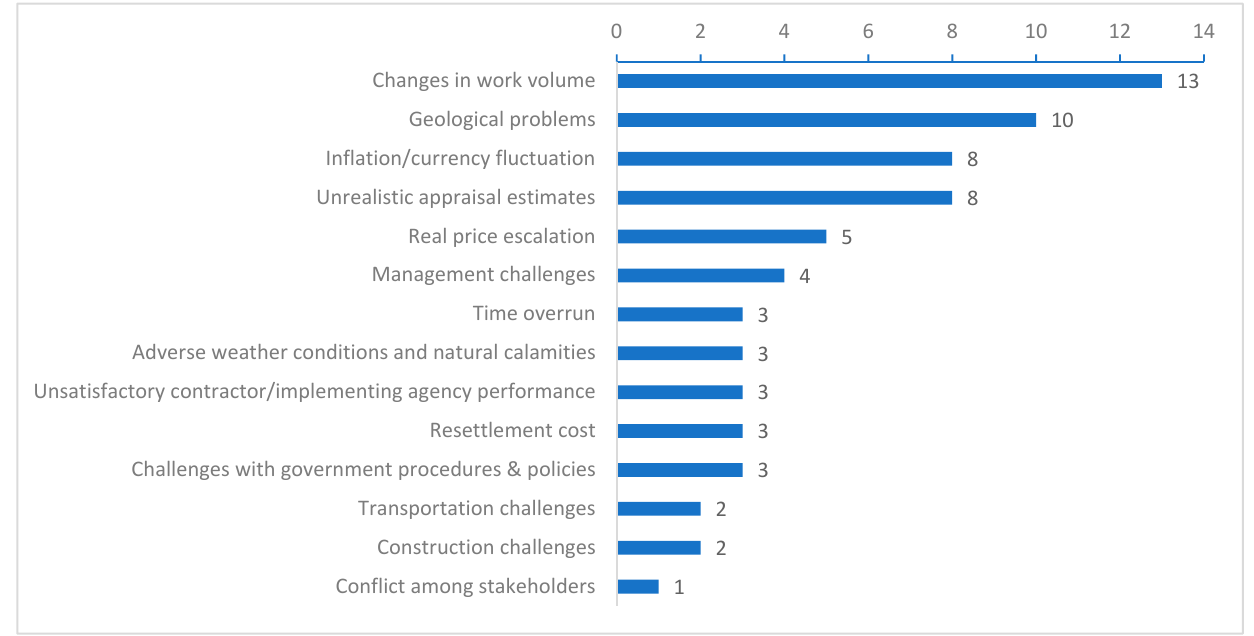
Figure 1. Causes of cost overruns (summary).